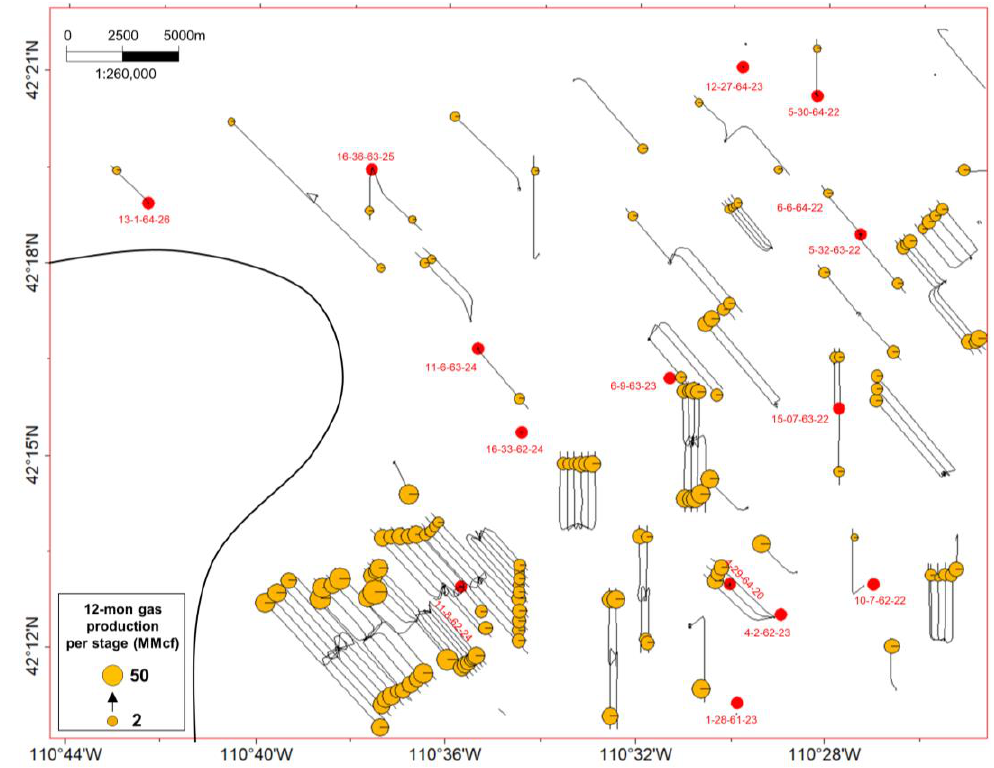
Figure 2. Locations of fractured horizontal wells and coring wells. The black line denotes the trajectory of horizontal wells. Coring wells are labeled with red color. The yellow circle represents the magnitude of the one-year gas production equivalence per stage for horizontal wells, scaled by production magnitude. The left black curve denotes the boundary line of the Duvernay formation.